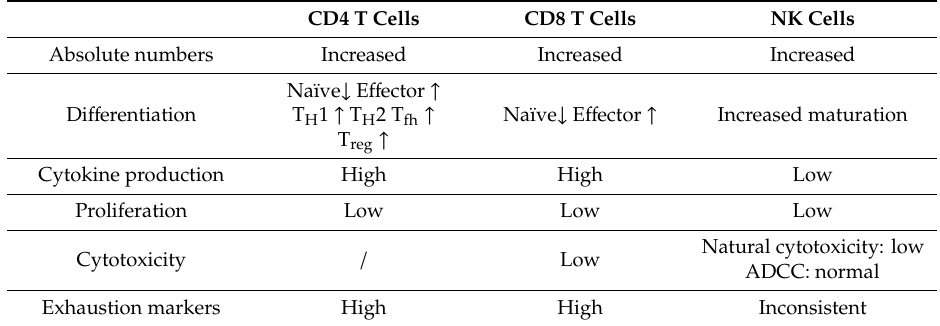
Table 1. Overview of permutations of T and natural killer (NK) cells in previously untreated chronic lymphocytic leukemia (CLL)